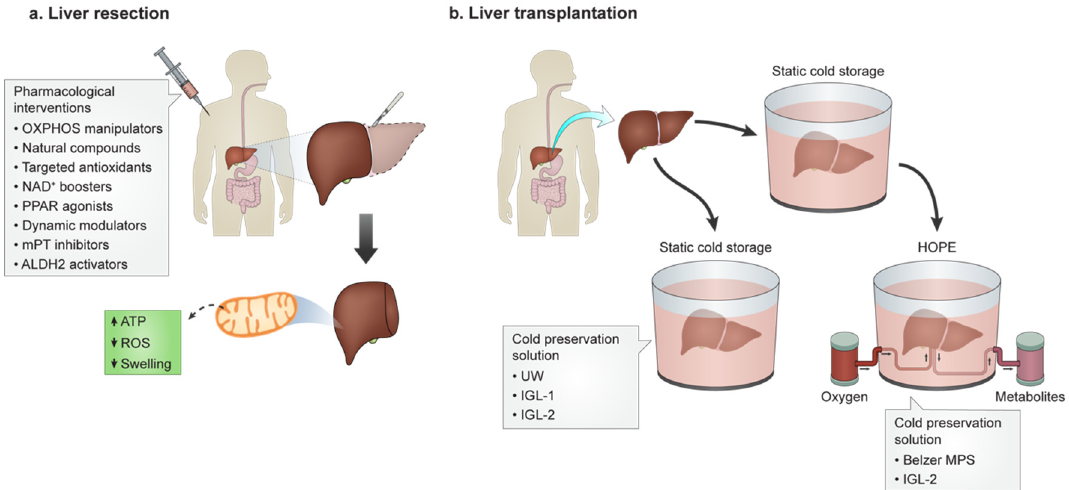
Figure 2. Interventions towards improved hepatic survival in liver surgery upon HIRI. ( a ) in liver surgeries where warm ischemia is required (for instance, in liver resection surgeries), preconditioning with mechanical (i.e., blood flow occlusion and restoration) or with pharmacological agents have been tested both in the bench and the bedside, with promising results. Of note is that, by directly or indirectly targeting mitochondria for function preservation, these strategies can make up for the difference in between failure or preservation and restoration of hepatic function, size and proficiency. ( b ) On the other hand, where cold ischemia is required (i.e., transplantation), new developments in preservation solutions have both increased the time window for which the organ is still in usable form, and also expanded the pool of organs that can be used, by virtue of the massively improved preservation protocols.